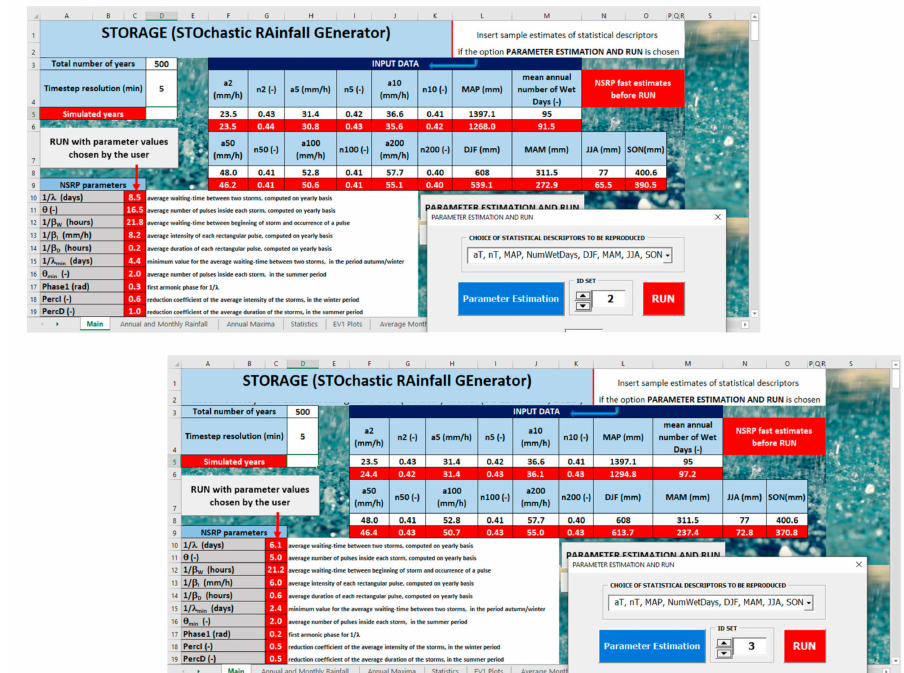
Figure 8. Example of calibration by using the spin button, which allows for using other parameter sets for simulation.